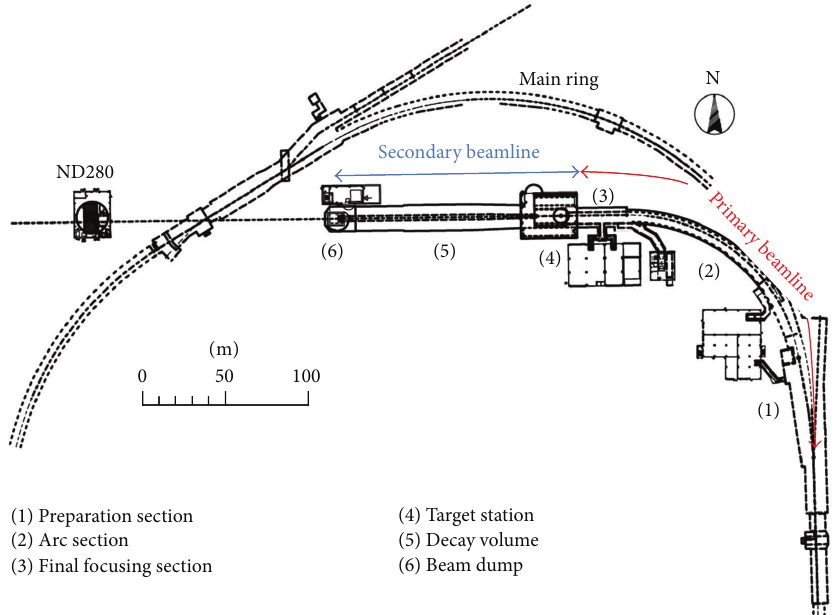
Figure 6: A schematic of the overall T2K beam facility showing the primary and secondary beamlines plus the location of the ND280 detector